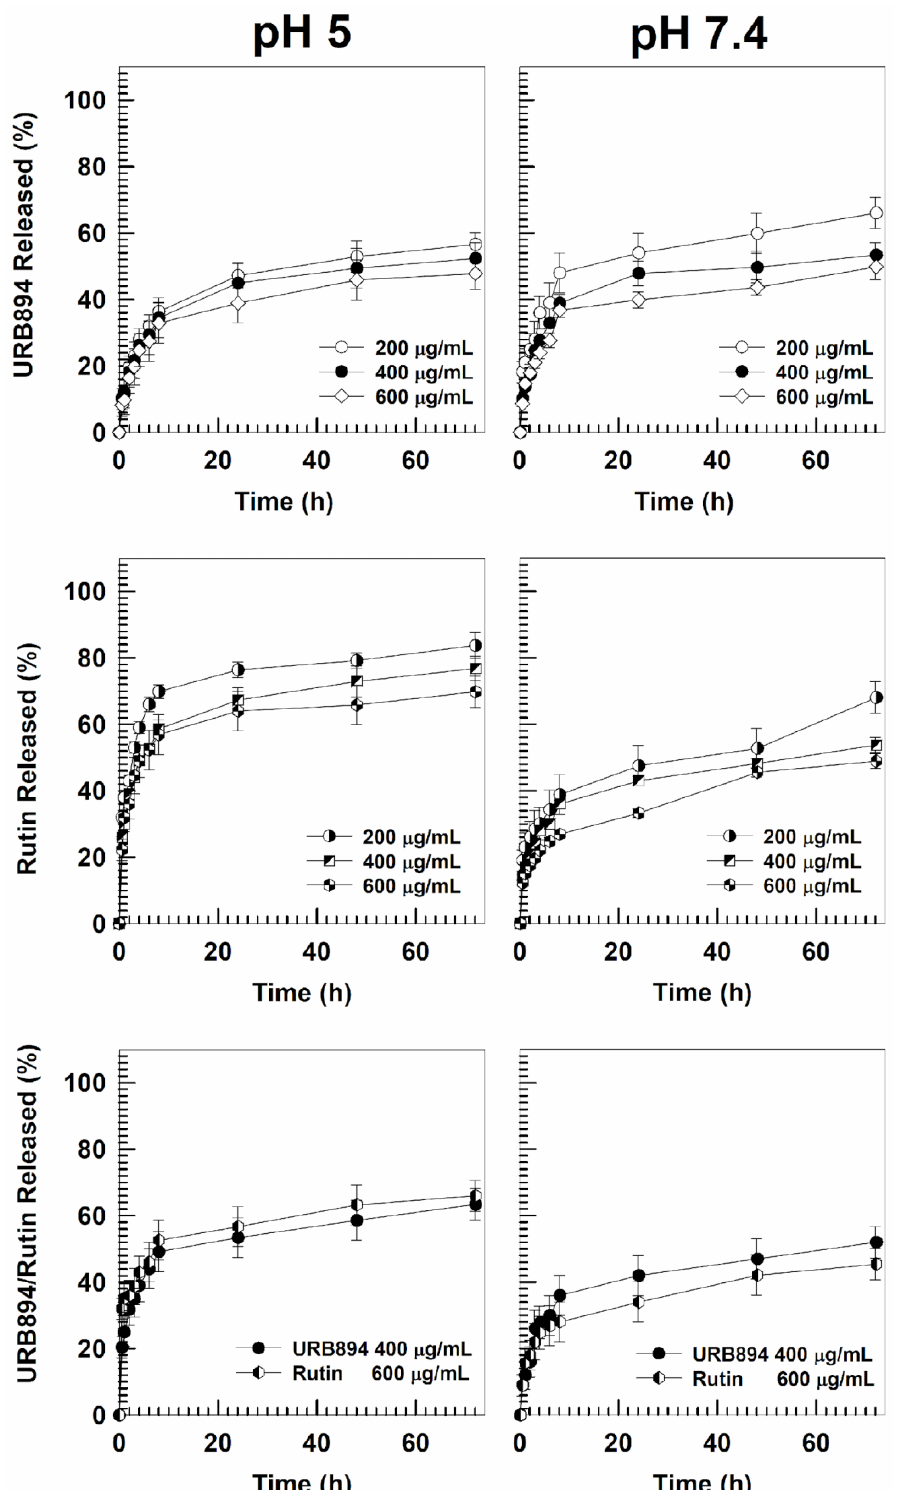
Figure 5. Release profiles of URB894 and rutin contained in PLGA nanoparticles as single agents or in association, in physiological and acidic conditions as a function of the amount of drug initially used and incubation time. The reported values represent the mean of three different experiments ± standard deviation. Error bars, if not shown, are within symbols.